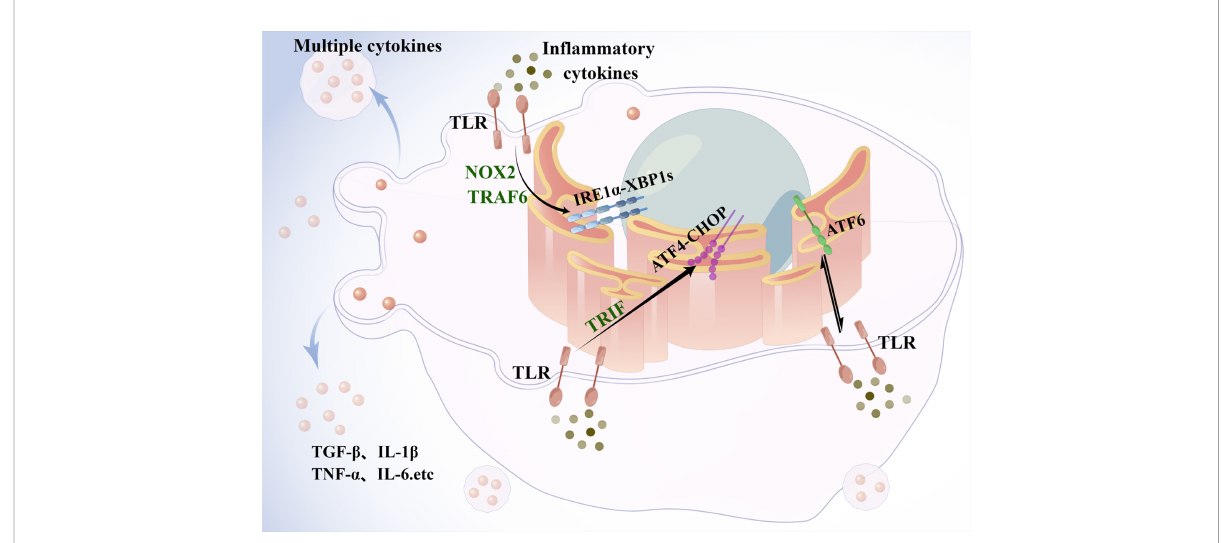
FIGURE 3 Endoplasmic reticulum stress in Kupffer cells. Under metabolic and in fl ammatory conditions, the UPR signaling pathway is activated in the ER. In macrophages, TLR signaling pathway induces ER stress, and TLR2 and TLR4 induce activation of IRE1 a , followed by activation of xbp1, through a mechanism that requires the NADPH oxidase NOX2 and TRAF6. ATF6, by mediating a proin fl ammatory synergy between ER stress and TLR activation is involved in the development of liver injury. The TLR signaling pathway adaptively inhibits the ATF4-CHOP branch of the UPR in a TRIF-dependent manner. Activated KCs then release cytokines such as TNF to act synergistically with other immune cells to exacerbate hepatic steatosis and fi brosis. TLR, toll-like receptor; TRAF6, TNF receptor-associated 6; TRIF, TIR structural domain-containing adapter-induced interferon- b